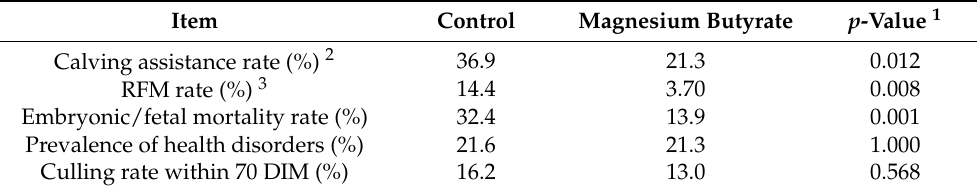
Table 5. Health-related parameters of Control ( n = 112) and Magnesium butyrate cows ( n = 107) diagnosed within the first 70